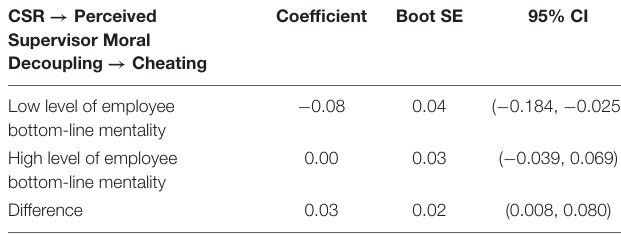
TABLE 4 | Bootstrapping results of mediation.